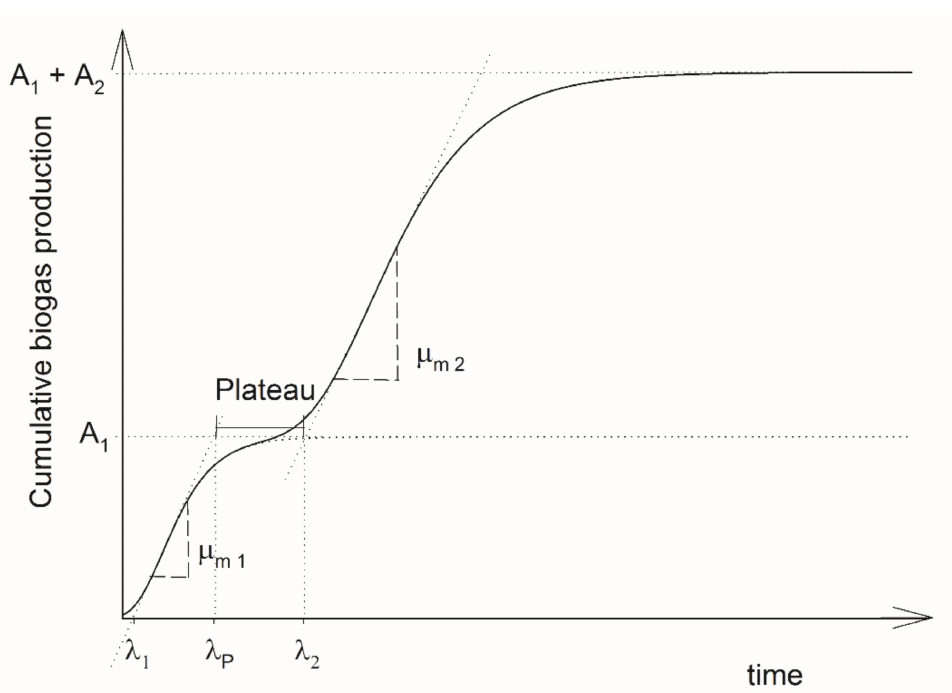
Figure 2. Two-phase Gompertz